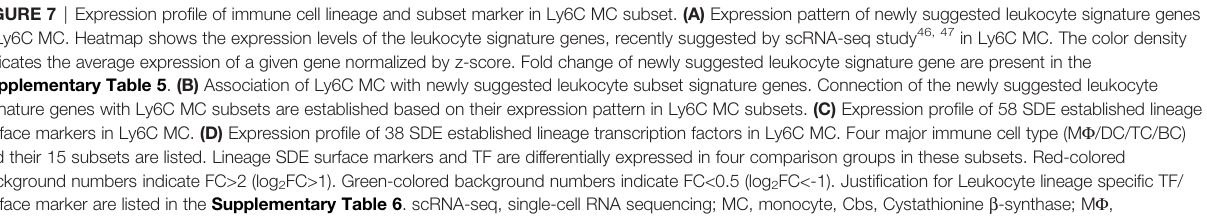
FIGURE 7 | Expression pro fi le of immune cell lineage and subset marker in Ly6C MC subset. (A) Expression pattern of newly suggested leukocyte signature genes in Ly6C MC. Heatmap shows the expression levels of the leukocyte signature genes, recently suggested by scRNA-seq study 46, 47 in Ly6C MC. The color density indicates the average expression of a given gene normalized by z-score. Fold change of newly suggested leukocyte signature gene are present in the Supplementary Table 5 . (B) Association of Ly6C MC with newly suggested leukocyte subset signature genes. Connection of the newly suggested leukocyte signature genes with Ly6C MC subsets are established based on their expression pattern in Ly6C MC subsets. (C) Expression pro fi le of 58 SDE established lineage surface markers in Ly6C MC. (D) Expression pro fi le of 38 SDE established lineage transcription factors in Ly6C MC. Four major immune cell type (M F /DC/TC/BC) and their 15 subsets are listed. Lineage SDE surface markers and TF are differentially expressed in four comparison groups in these subsets. Red-colored background numbers indicate FC>2 (log 2 FC>1). Green-colored background numbers indicate FC<0.5 (log 2 FC<-1). Justi fi cation for Leukocyte lineage speci fi c TF/ surface marker are listed in the Supplementary Table 6 . scRNA-seq, single-cell RNA sequencing; MC, monocyte, Cbs, Cystathionine b -synthase; M